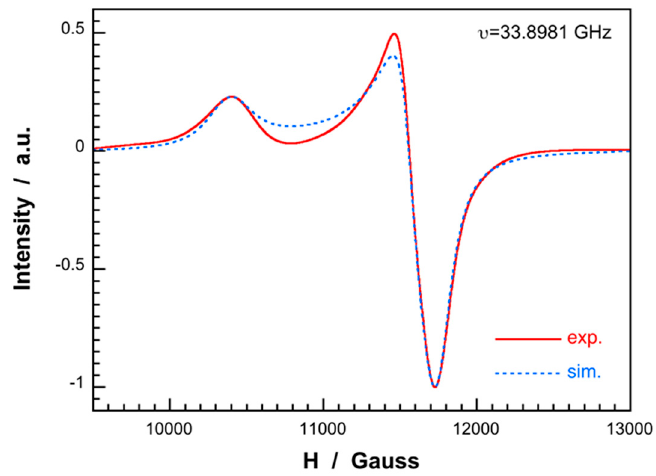
Figure A7. Q-band ESR powder spectrum of compound 1 registered at room temperature. Dotted line is the best fit; see text for the fitting parameters.